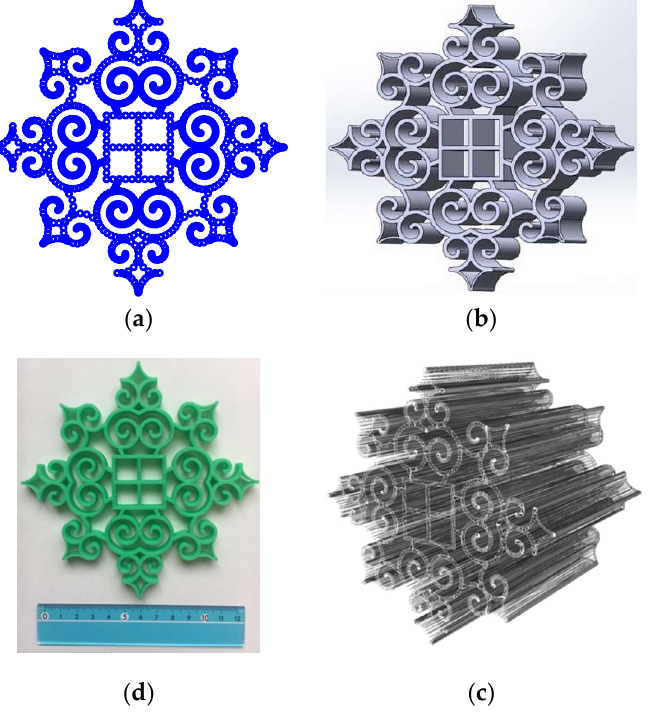
Figure 13. Model-2 based on Ainu motifs. ( a ) Point-cloud; ( b ) Solid CAD model; ( c ) Triangulation data; ( d ) Physical model built by 3D printing.